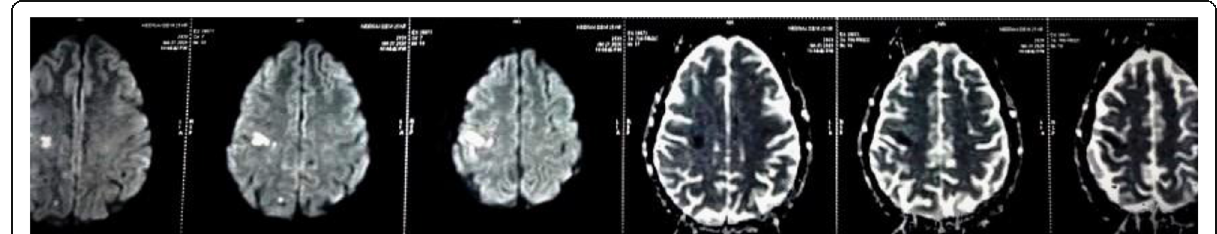
Fig. 2 MRI brain diffusion weighted image showing right parietal